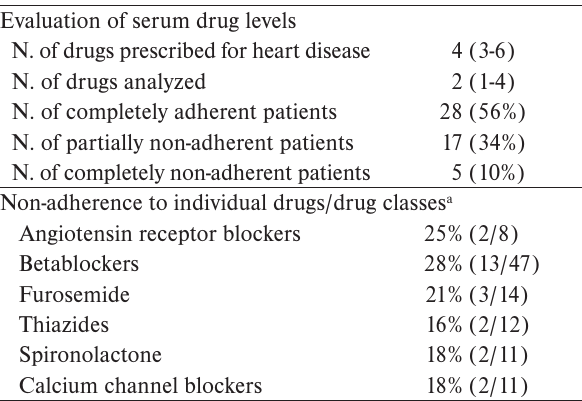
Table 2. Adherence